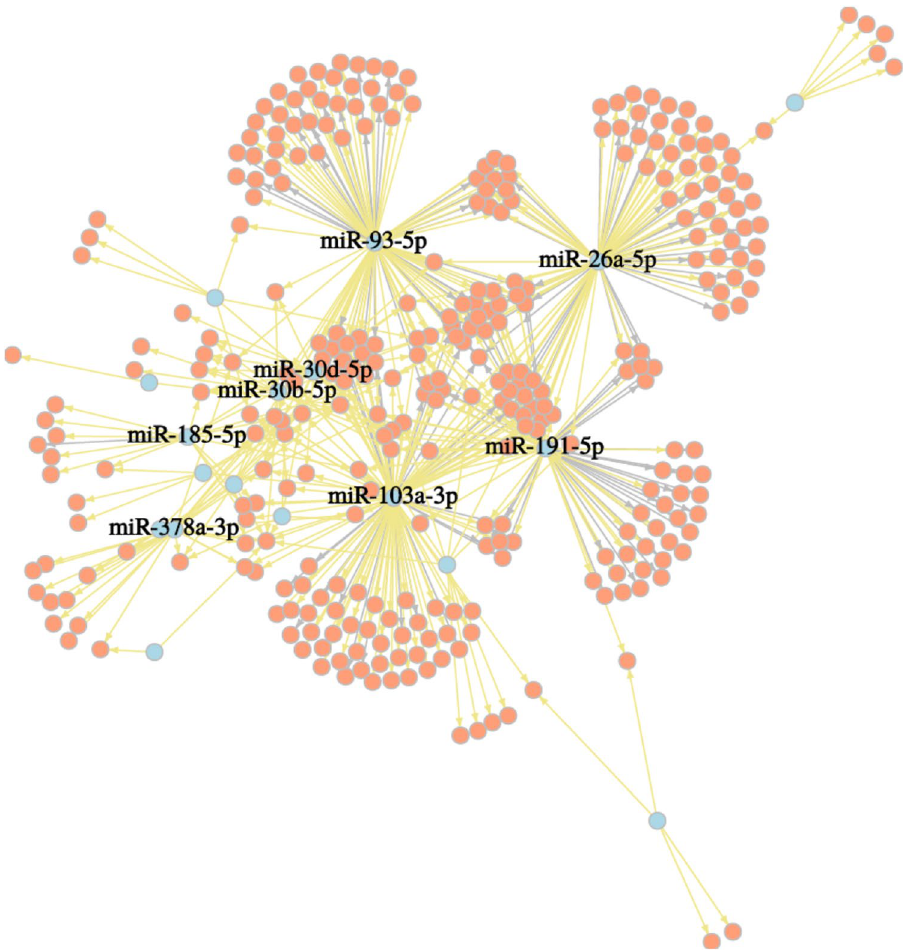
Figure 5. Correlation network of miRNAs that were differentially expressed in MI patients compared to the control samples in the nonclassical monocyte subset. Illustrated are just pairs that correlated more than ± 0.85 (Pearson’s r) and miRNAs having more than 10 targets. Negative correlations are highlighted in yellow, miRNAs in blue and targets in